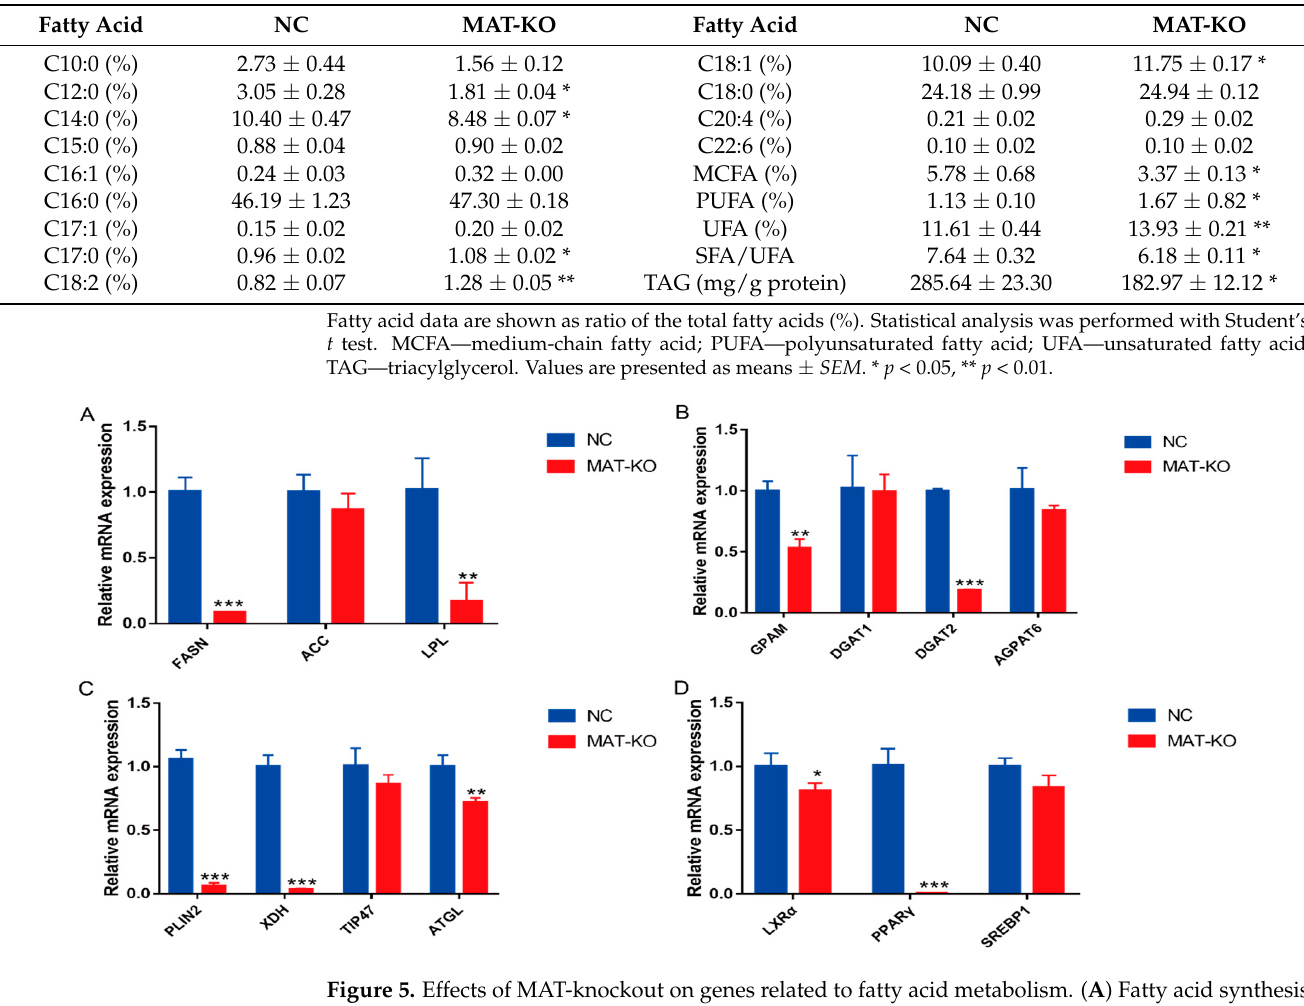
Figure 5. Effects of MAT-knockout on genes related to fatty acid metabolism. ( A ) Fatty acid synthesis and triacylglycerol hydrolysis. ( B ) Triacylglycerol synthesis ( C ) Lipid droplet formation, secretion and hydrolysis. ( D ) Regulatory factors. NC—negative control group; MAT-KO—knockout group; values are means ± SEM for three independent experiments. * p < 0.05, ** p < 0.01, *** p < 0.001.